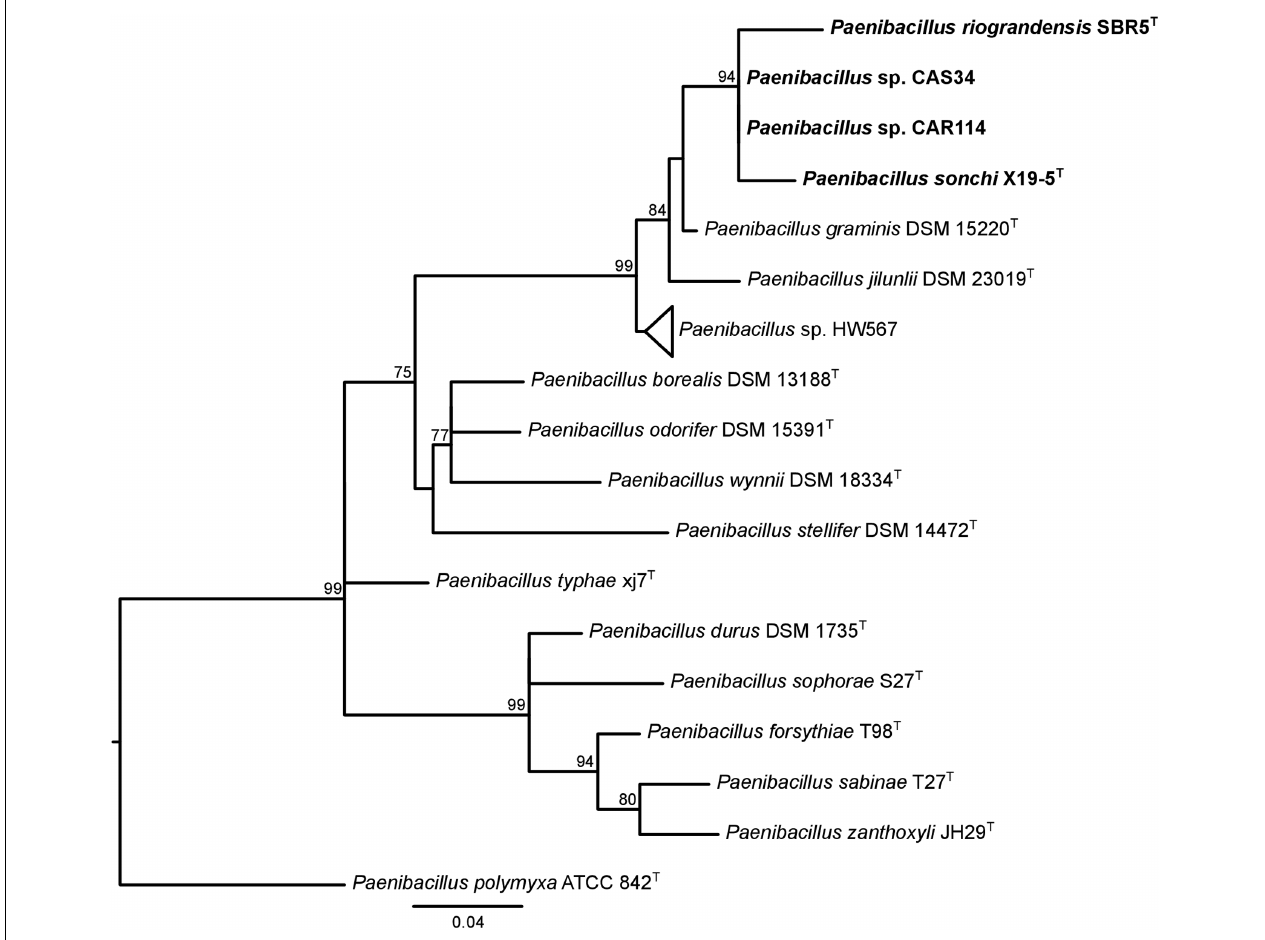
FIGURE 1 | 16S rRNA gene phylogeny of Paenibacillus species. The 16S rRNA gene rooted tree was constructed using the maximum-likelihood method. aLRT values greater than 70% are shown next to the branches. The tree is drawn to scale, with branch lengths in the same units as those of the evolutionary distances used to infer the phylogenetic tree. P. polymyxa is the outgroup. Bacteria of P. riograndensis/P. sonchi clade are in bold. This tree is the same of Supplementary Figure S2, although only taxa of interest were